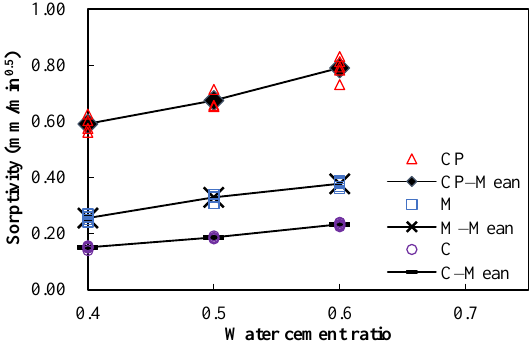
Figure 6. Sorptivity of undamaged specimens.